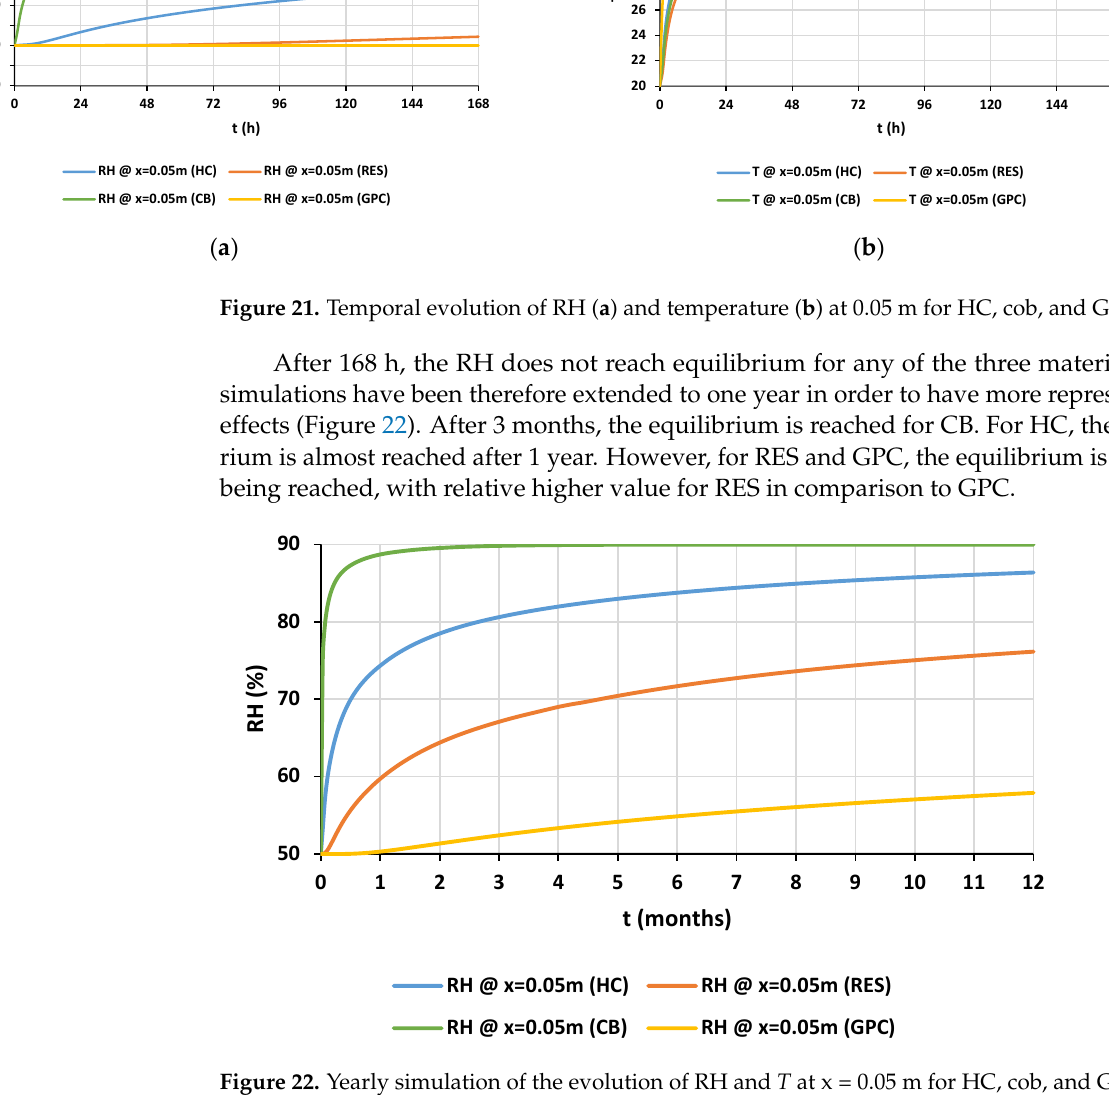
Figure 22. Yearly simulation of the evolution of RH and T at x = 0.05 m for HC, cob, and GPC. From the numerical simulation, it appeared that RES provides the wall with a good thermal inertia with acceptable moisture regulation ability.